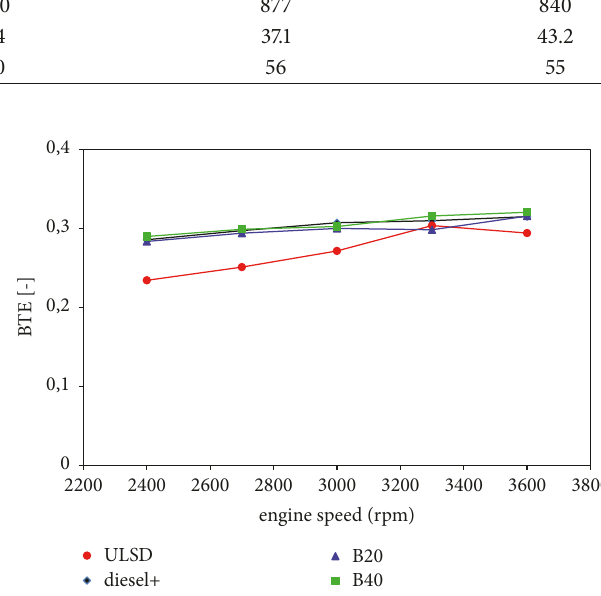
Figure 4: Brake specific fuel consumption variation with engine speed at 80%